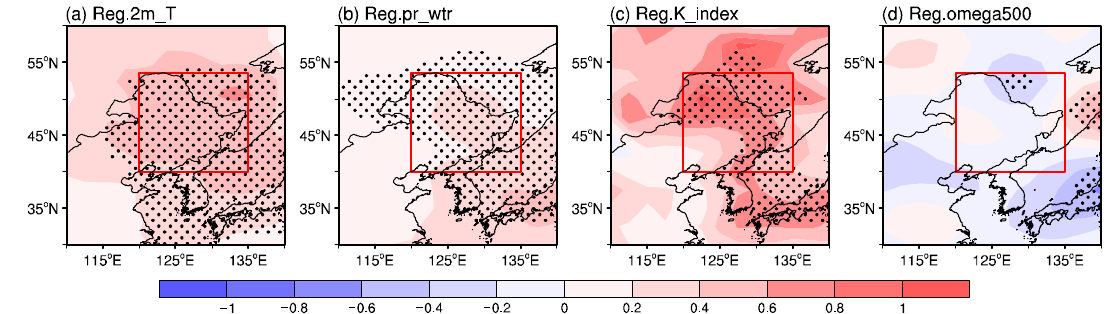
Figure 11. Regression coefficients of Kuroshio Extension SST index in wintertime from 1965 to 2013 by climatic element: ( a ) 2-m air temperature (units: °C); ( b ) precipitable water (units: kg m − 2 ); ( c ) K-index (units: K); ( d ) 500 hPa vertical velocity (units: 10 − 2 Pa s − 1 ). Stippling denotes where anomalies are significant at the 90% confidence level.